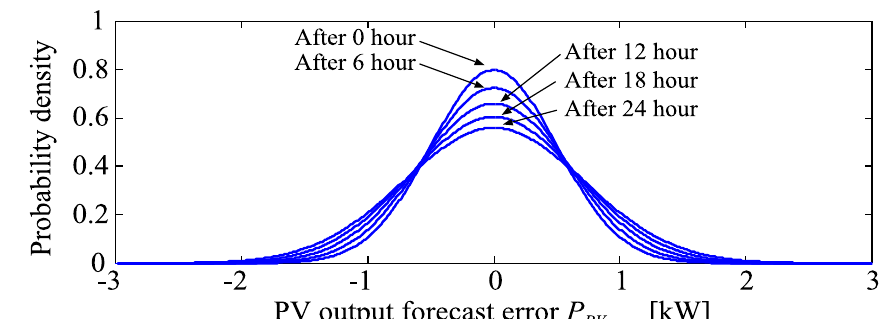
Figure 5. Flow chart in optimization.